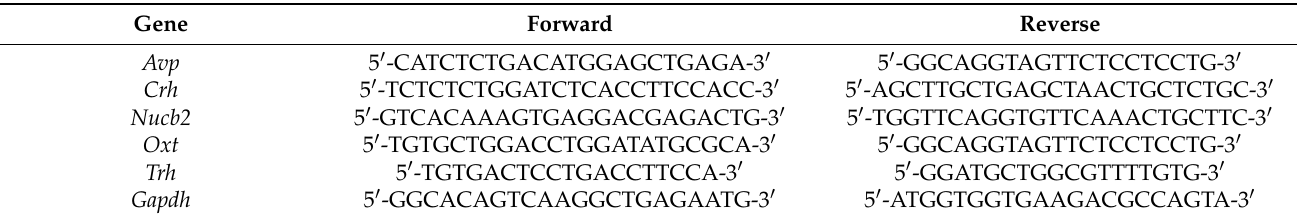
Table 1. Primers used in the RT-PCR